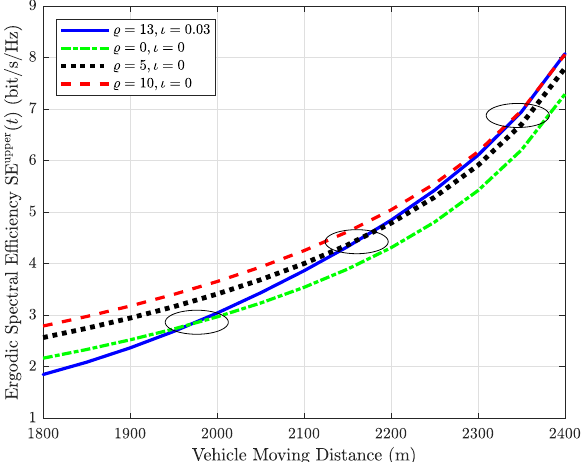
Figure 5. Ergodic SE for one vehicle pass with the distance-dependent Rician factor ( (cid:36) = 13, ι = 0.03) [20] and fixed Rician factors ( (cid:36) = 0, ι = 0; (cid:36) = 5, ι = 0; (cid:36) = 10, ι = 0 [19]). The moving distance of the vehicle is from 1800 m to 2400